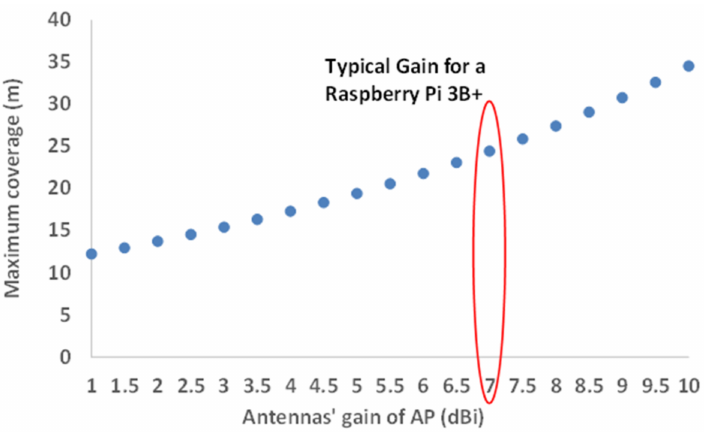
Figure 7. Coverage for our system considering all